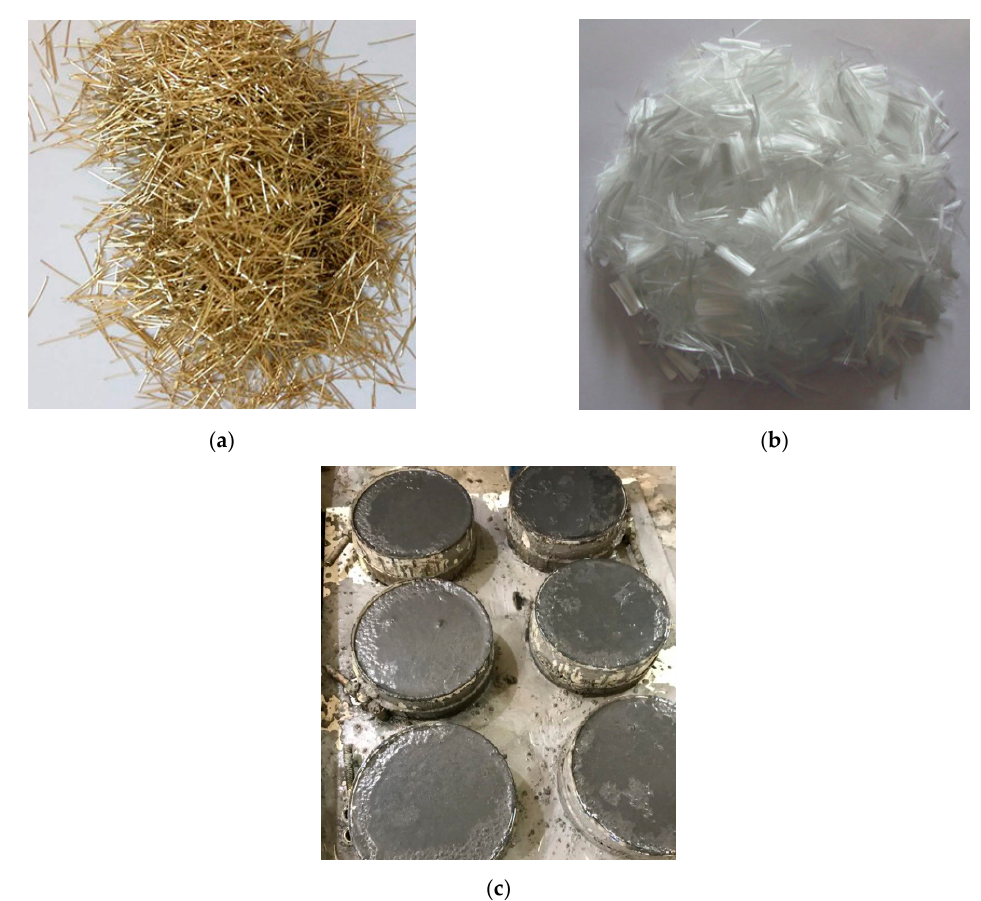
Figure 1. The used ( a ) micro-steel fibers, ( b ) polypropylene fibers, and ( c ) the cast disc specimens. Table 1. Mix proportions of the six ultra-high performance fiber-reinforced concrete ( UHPFRC ) mixtures.